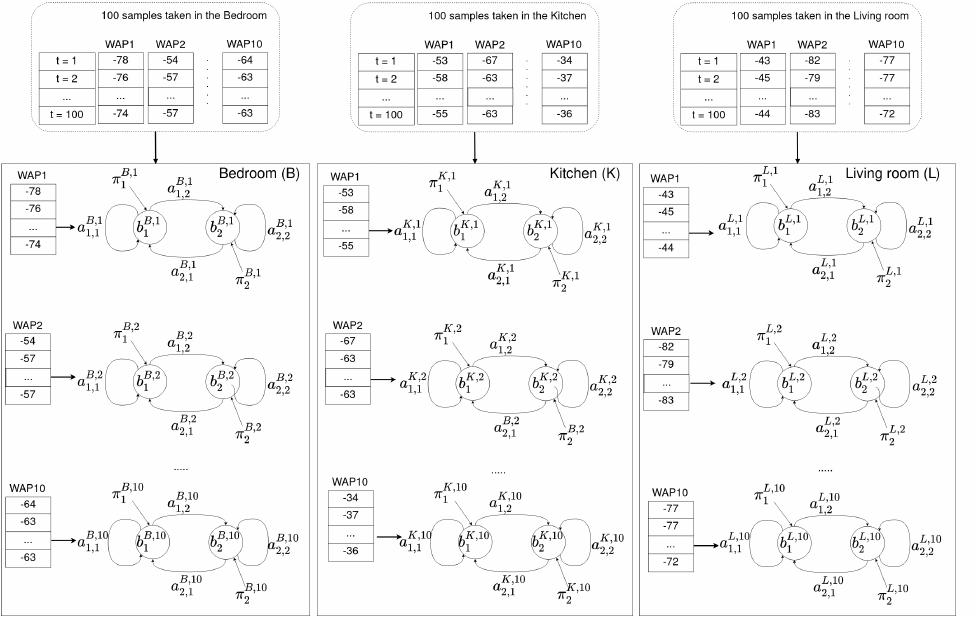
Figure 5. An example of an offline phase. For each room (bedroom, kitchen, and living room), and for each time series received from a WAP present in the environment (10 in this example), an HMM was built. Note that the set of training samples is different for the three locations: bedroom, kitchen, and living